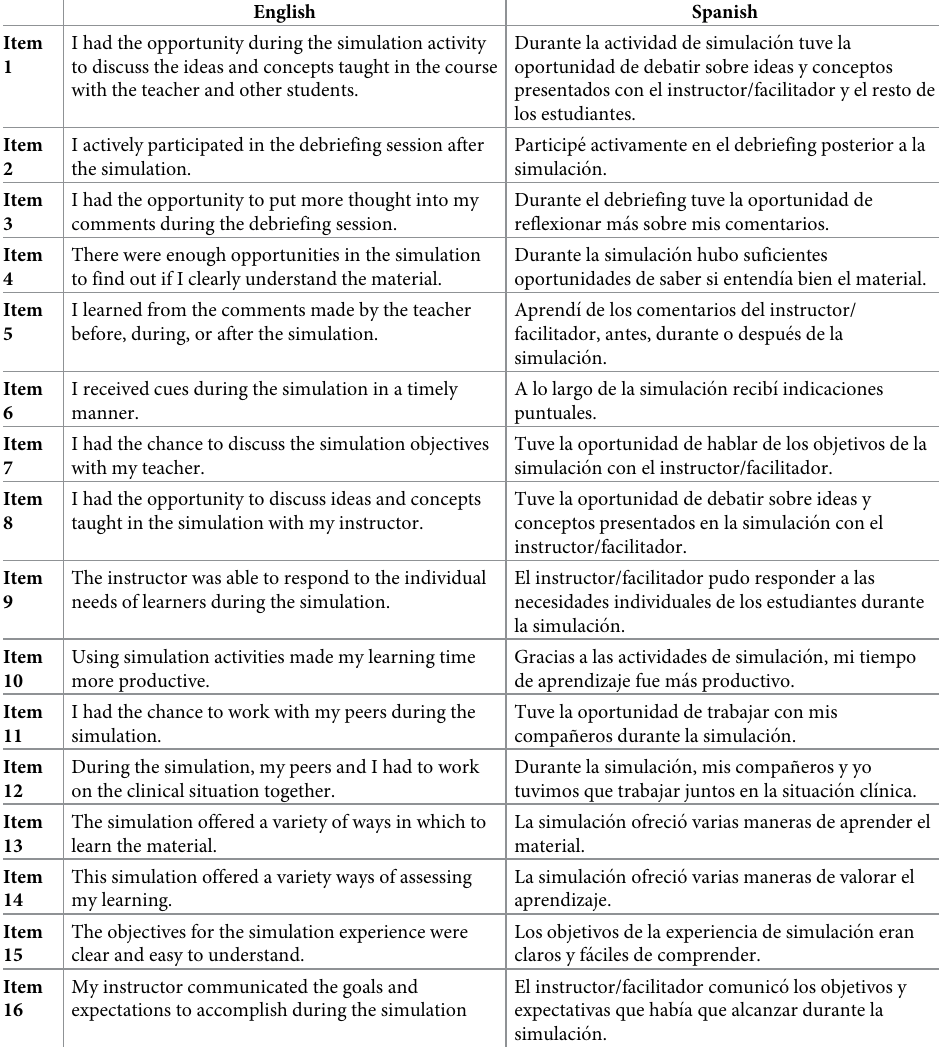
Table 1. Shows the semantic equivalence of items from English to Spanish that were metrically